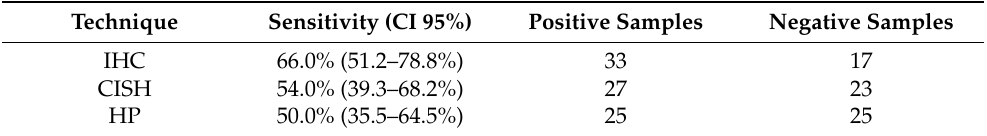
Table 1. Sensitivity for the detection of amastigote forms found by IHC, CISH, and HP and the number of positive and negative samples for each of these techniques were assessed for 50 samples fixed in 10% formalin and paraffin-embedded cutaneous lesions from patients with new world cutaneous leishmaniasis caused by L. ( V. ) braziliensis .